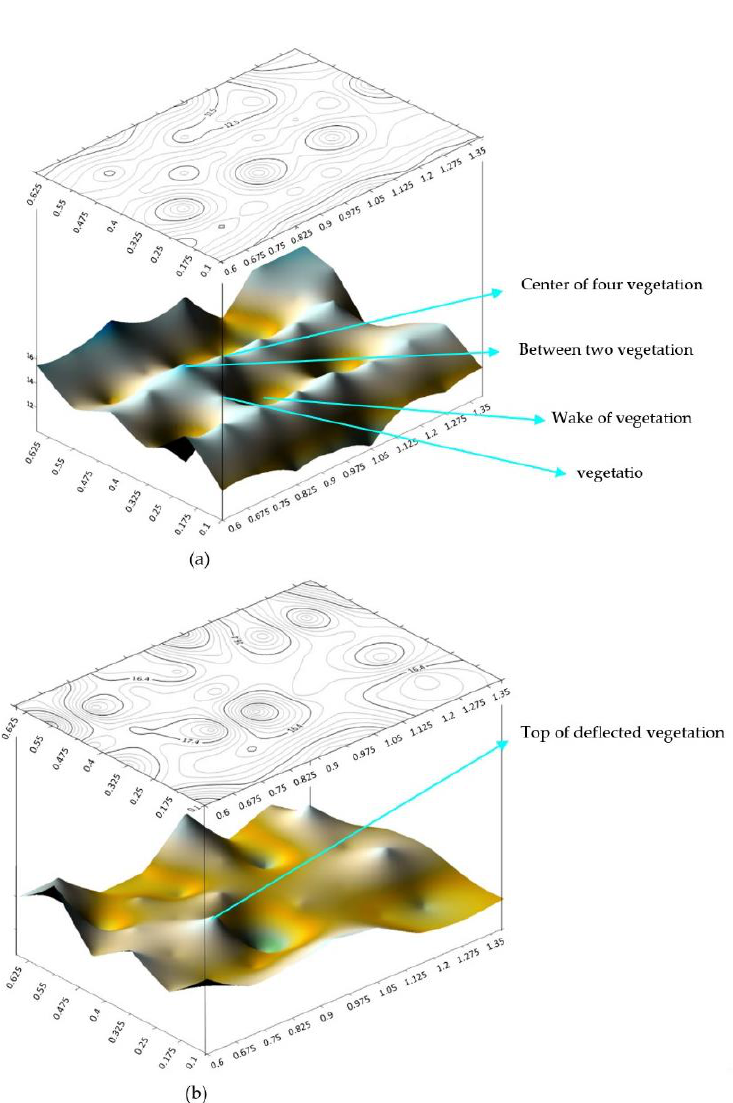
Figure 11. Contours and 3D velocity graphs in vegetation with density of λ = 0.09 at ( a ) near the bed at the depth of z/H = 0.1; ( b ) top of deflected vegetation at the depth of z/H = 0.4. Compared to that TKE measured between two vegetation elements and those in the center of squares formed by four vegetation elements (vegetation-free streamline), as shown in Figure 12, the TKE was significantly enhanced by vegetation. In this study, this trend will be discussed in greater